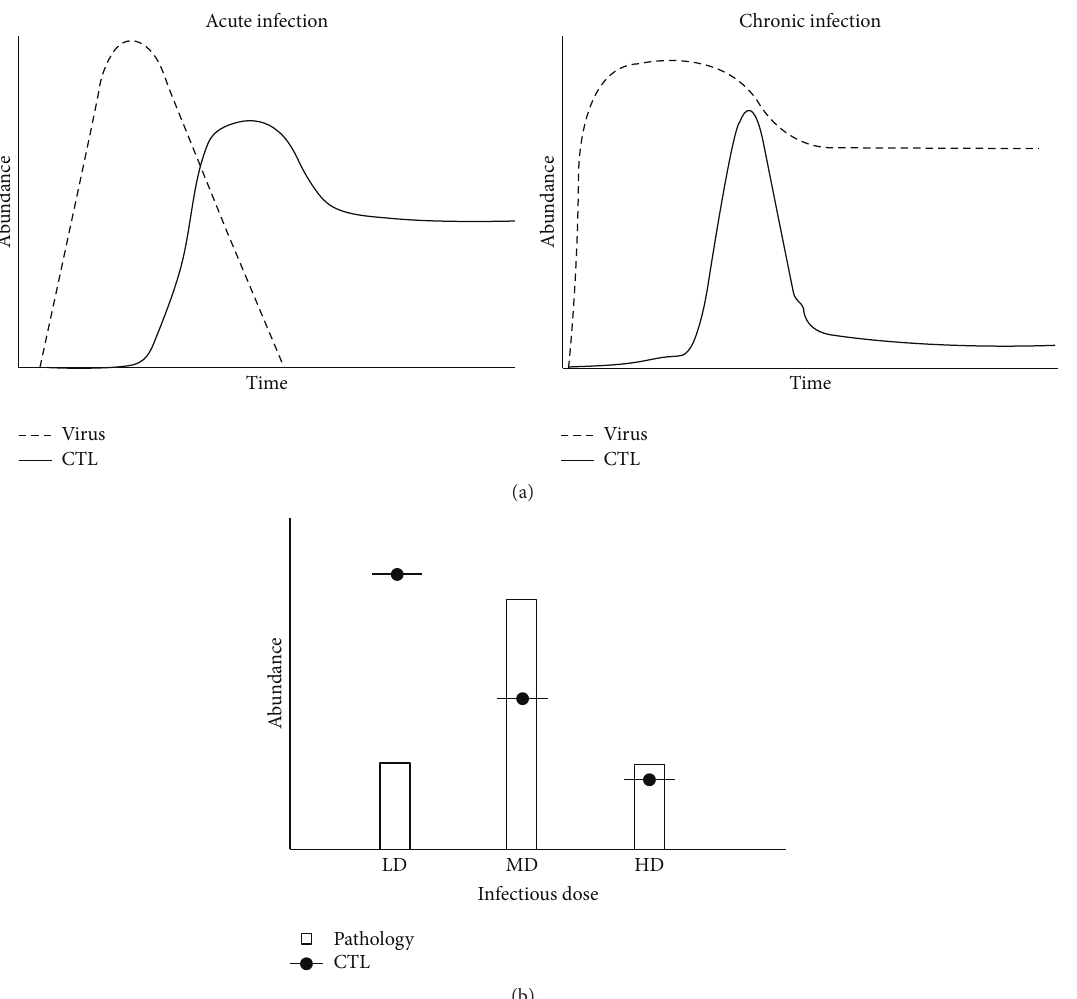
Figure 1: (a) Schematic view of acute and chronic LCMV infections including virus and cytotoxic T lymphocyte (CTL) dynamics. (b) Representation of the CTL-induced immunopathology dependence on the initial viral infectious dose at day 13 after infection (adapted from Cornberg et al. [62]). LD: low-dose infection; MD: medium-dose infection; HD: high-dose